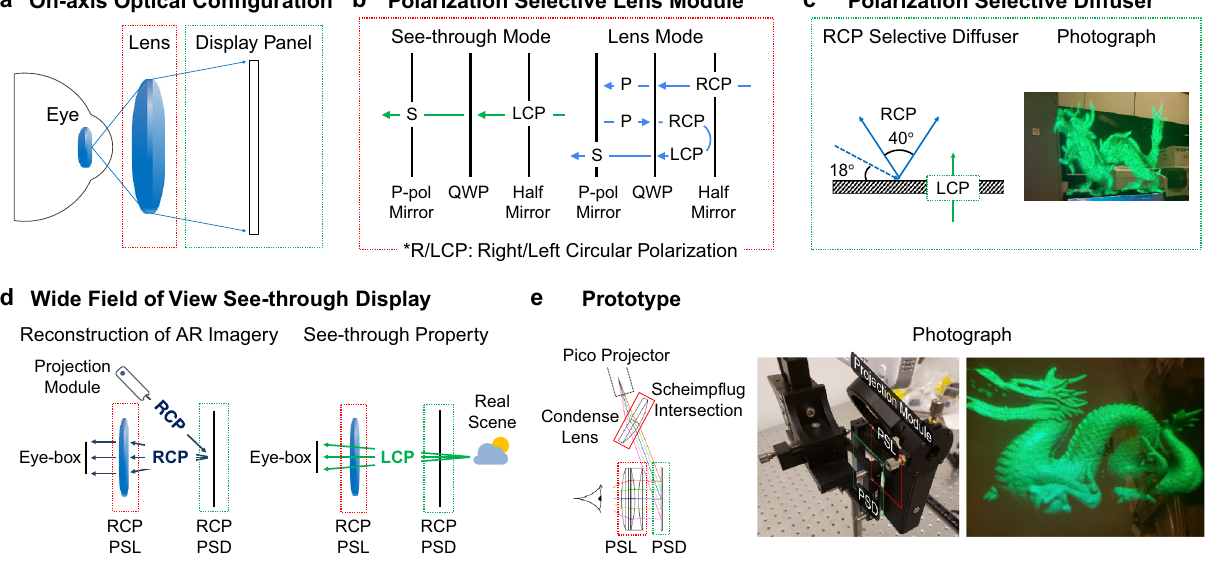
Figure 1. Illustration of peripheral display with wide field of view. ( a ) On-axis optical configuration that has advantages in the field of view and the eye-box. ( b ) Detailed structure of the PSL module that has two modes (lens or see-through) according to the circular polarization state. ( c ) The optical characteristics (i.e. angular and polarization selectivity) of a PSD. The PSD can be a transparent projection screen as shown in the photograph. ( d ) Proposed peripheral display combining two polarization selective optical elements: the PSL module and the PSD. Two figures describe how AR imagery and real-world scene are superimposed in the display system. ( e ) Photographs of a prototype implemented for the peripheral display. The optical aberration involved by the slanted projection is corrected by a condense lens with Scheimpflug intersection principle 6